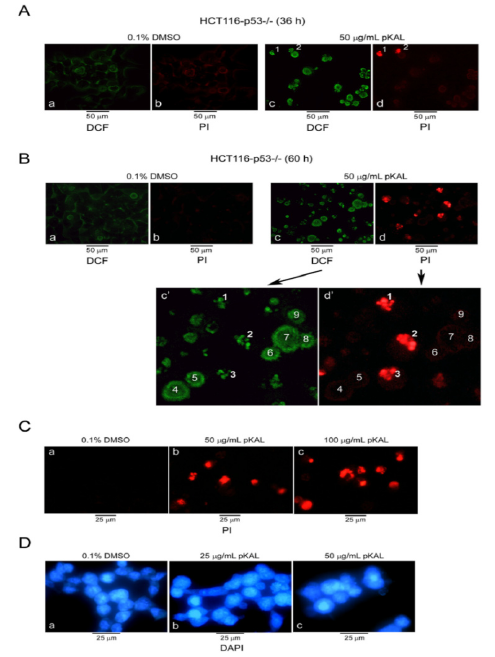
Figure 1. Effects of polyphenols isolated from Korean Artemisia annua L. (pKAL) on reactive oxygen species (ROS) production, propidium iodide (PI) uptake, and nuclear structure change in p53-null HCT116 cells. HCT116-p53 − / − cells were cultured with treatment of DMSO or pKAL at the indicated concentrations and times. ( A , B ) Cells were co-stained with 5 µ M DCF-DA and 1 µ g / mL PI for 20 min in a 37 ◦ C CO 2 incubator, and fluorescent images of green (DCF) and red (PI) were visualized by fluorescence microscopy. ( C ) PI staining. ( D ) DAPI staining.